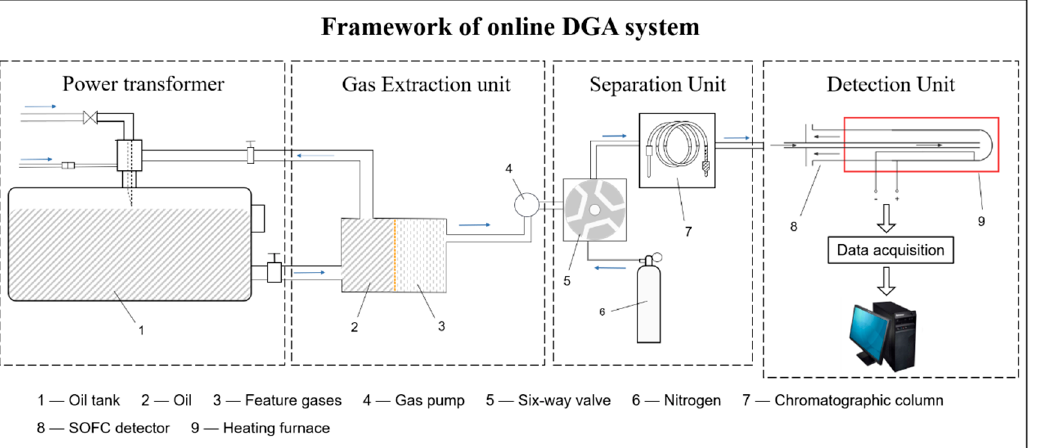
Figure 1. Framework of the DGA monitoring system.